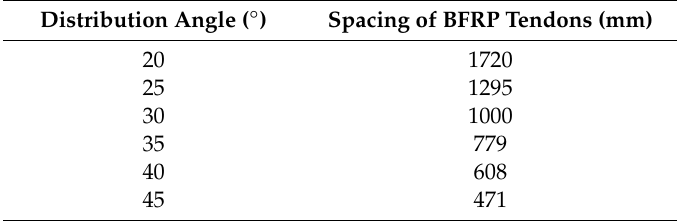
Table 1. The spacing of basalt fiber-reinforced polymer (BFRP) tendons at different distribution angles (mm). Distribution Angle ( ◦